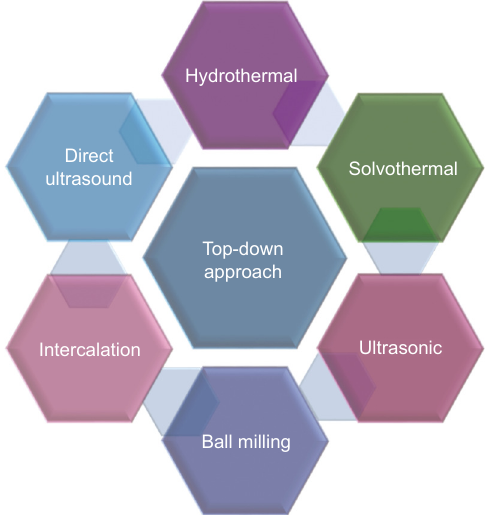
Fig. 1 | Top-down approaches for MQD